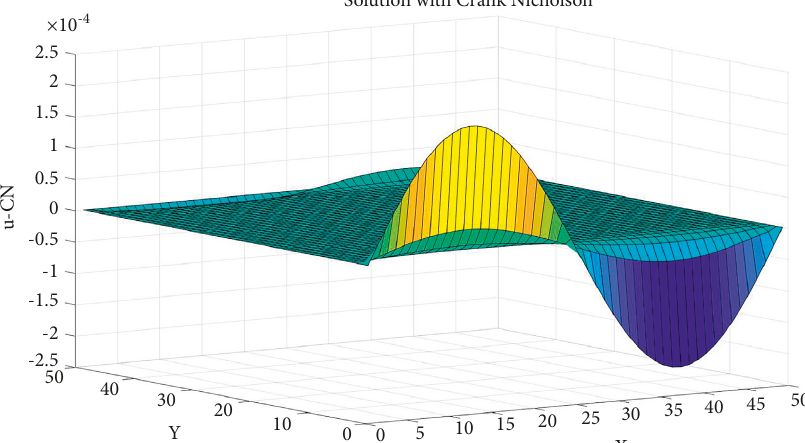
Figure 3: Numerical solution of the CN scheme at � 30 × 30 grid size, k � 0 . 01, and ϵ � 0 .